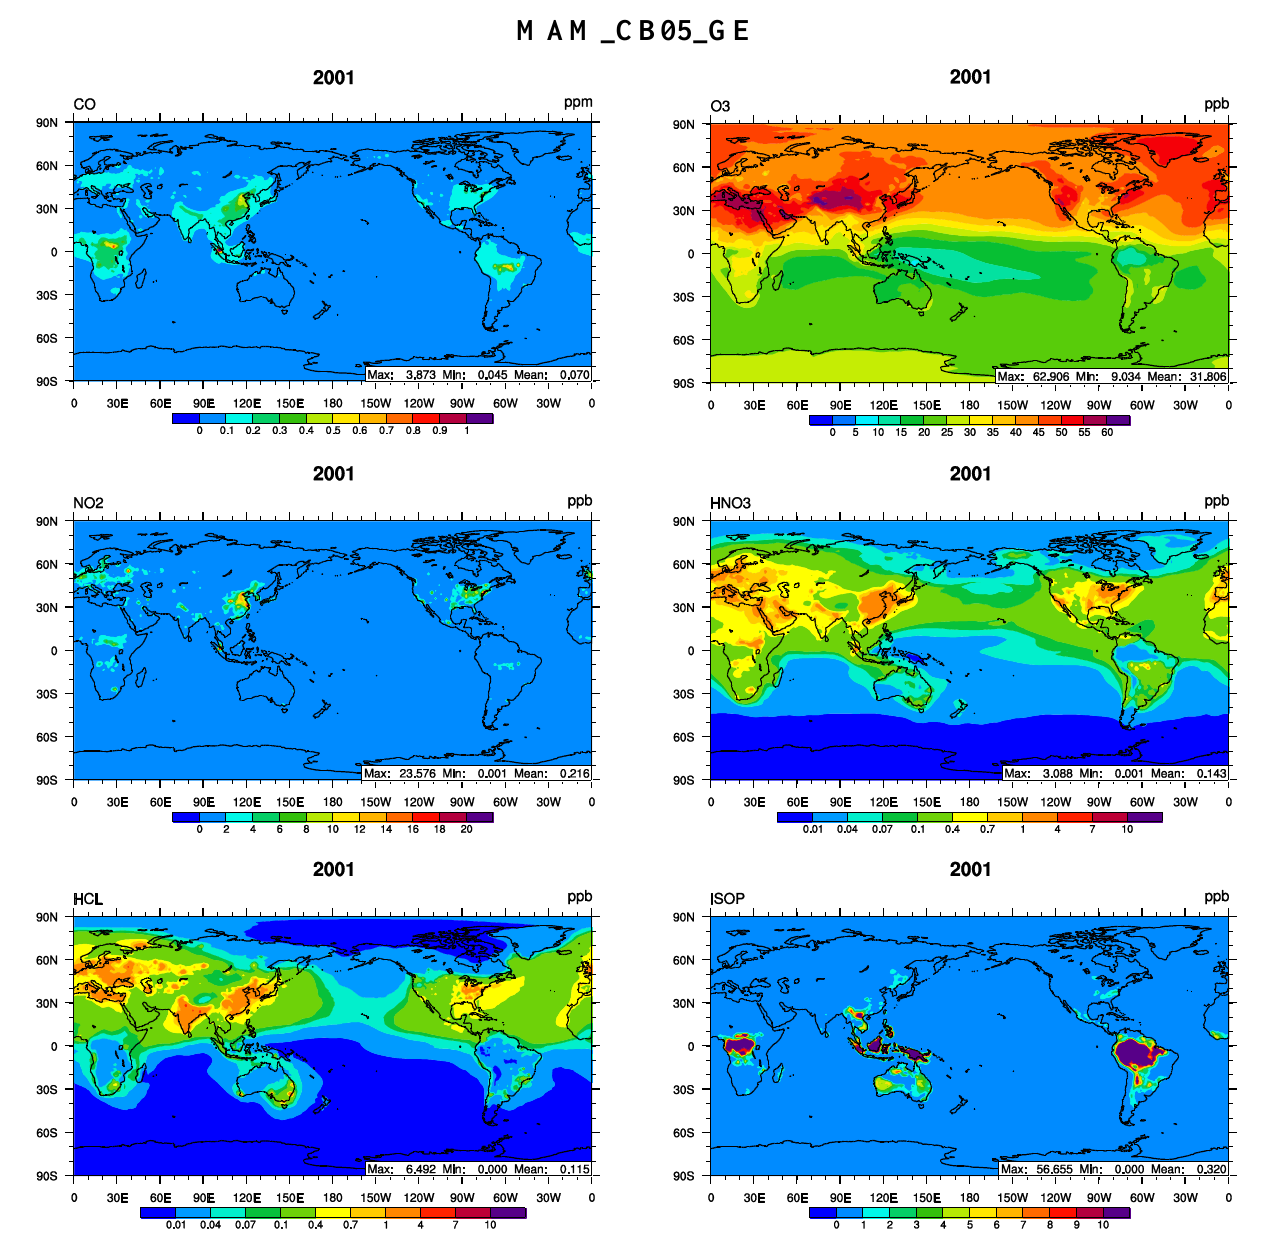
Figure 2. Surface distribution of CO, O Figure 2. Spatial distributions of CO, O 3 , NO 2 , HNO 3 , HCl, and isoprene (ISOP) at the surface simulated by MAM_CB05_GE for MAM_CB05_GE for 2001.